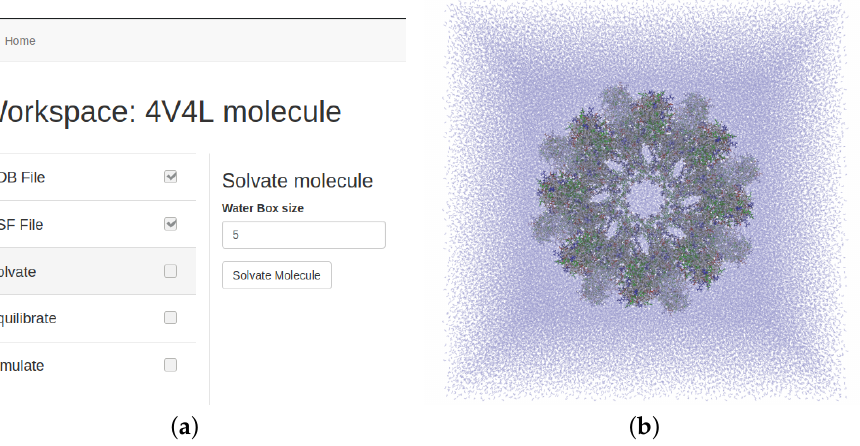
Figure 10. Stage of adding water solution: ( a ) shows a snapshot where users specify the solvation box’s size. In ( b ), a 4V4L molecular system is inside of a solvation